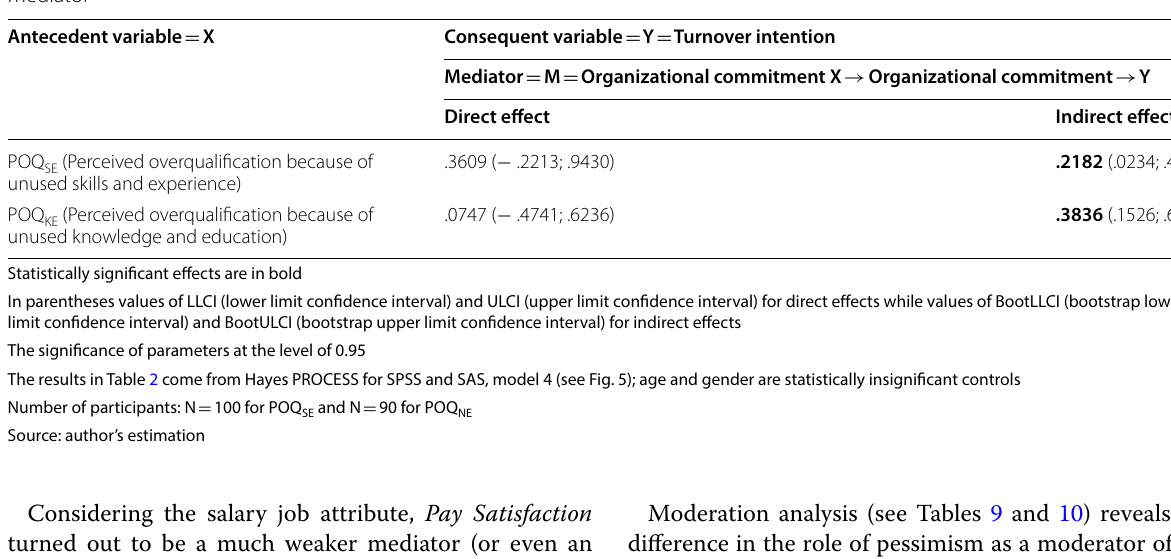
Table 2 Direct and indirect effects of perceived overqualification on turnover intention with organizational commitment acting as a